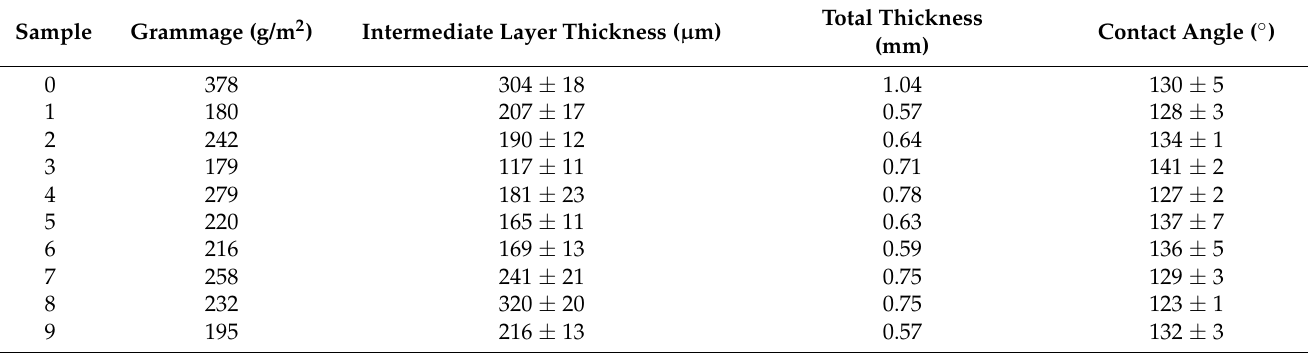
Table 3. Morphological characteristics of the face masks and water contact angle of the external layers.